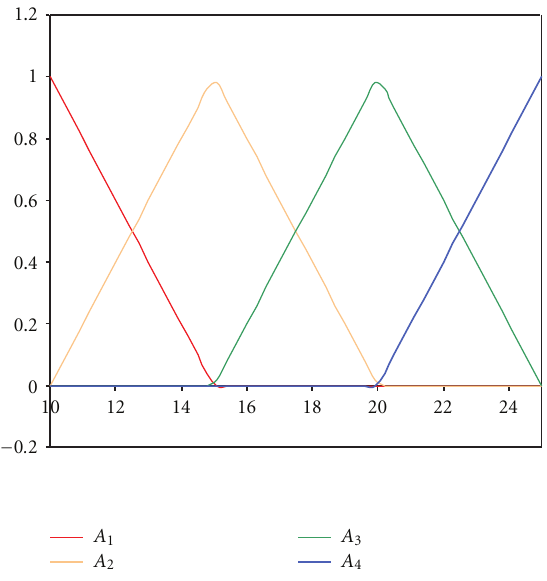
Figure 1: Example of triangular basic functions.